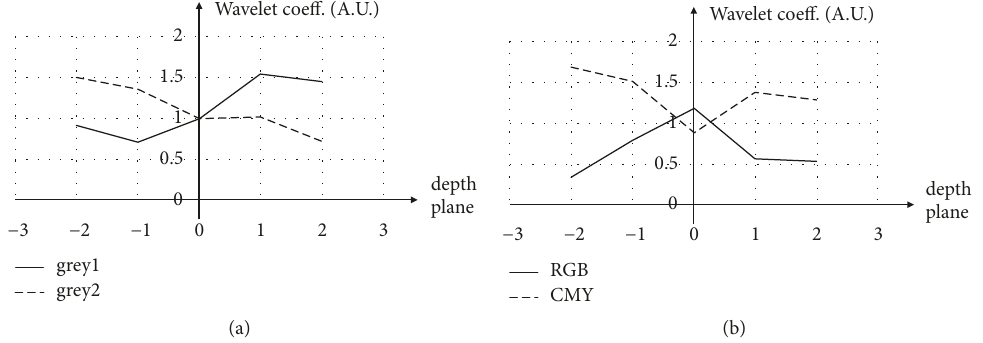
Wavelet coeff. (A.U.)